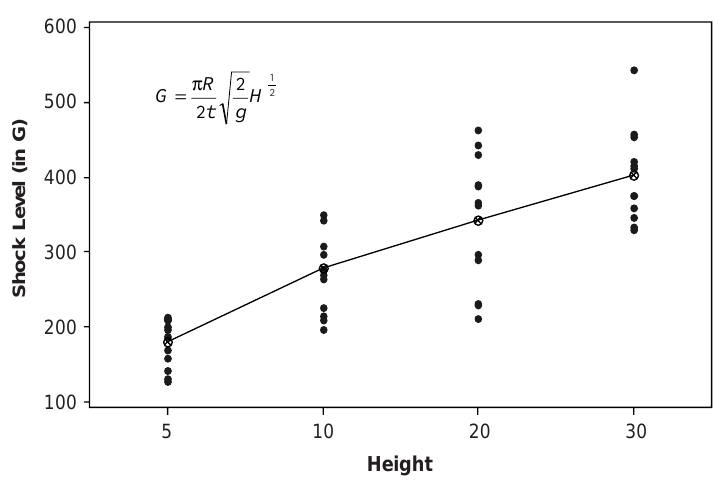
Fig. 5. Component’s shock response in MP3 player due to free drop.